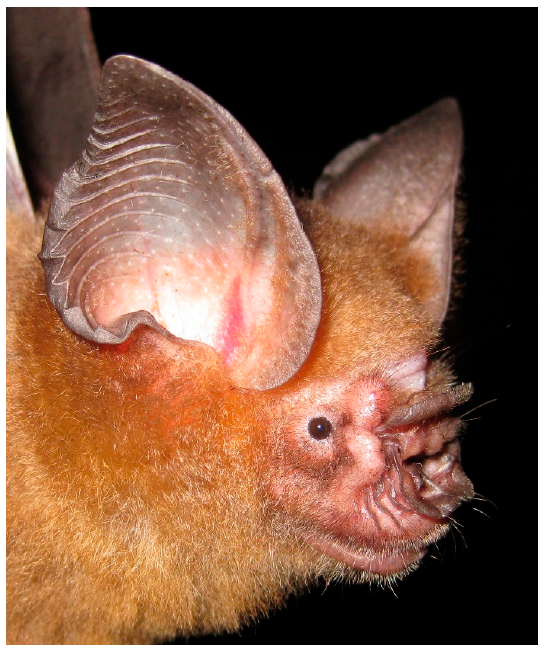
Figure 11. Hipposideros alongensis , adult male. Photograph by Vu Dinh Thong.